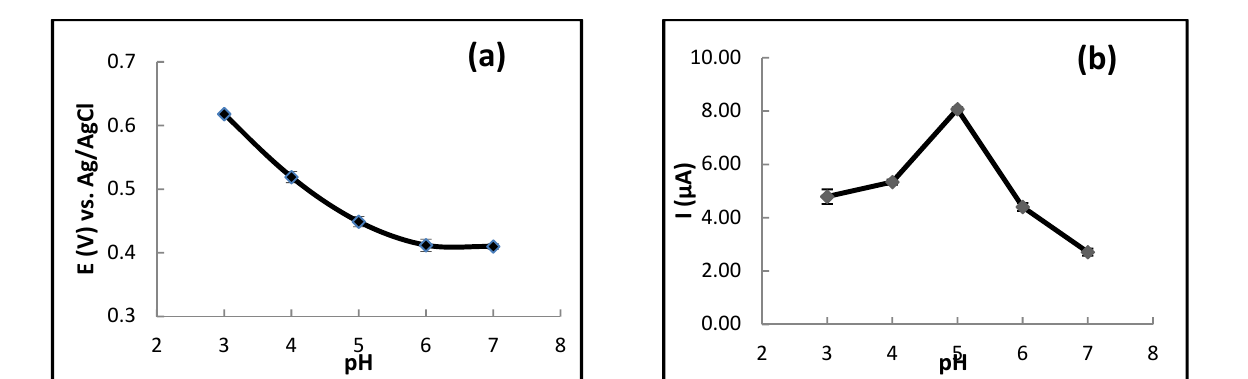
Figure 3. The influence of the electrolyte pH on the ( a ) oxidation peak potential, and the ( b )oxidation peak current. Other conditions are the same as in Figure 2. Data are shown as the mean ± 1 SD and are derived from 3 independent